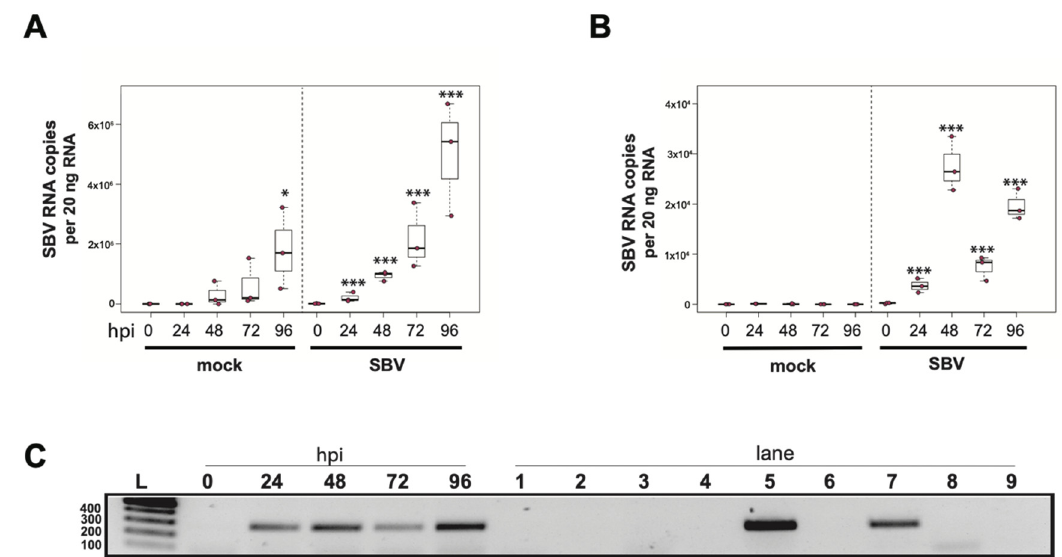
Figure 1. Sacbrood virus (SBV) naturally infects hemocytes and replicates in primary honey bee hemocyte cell cultures. SBV abundance was assessed in mock- or SBV-treated larval hemocytes by qPCR over a time course (i.e., 0 hpi, 24 hpi, 48 hpi, 72 hpi, and 96 hpi). ( A ) Cells isolated from asymptomatic larvae and treated with PBS (pH 7.4) had a 501 × increase in mean SBV abundance by 96 hpi relative to 0 hpi ( p = 0.042), indicating that the hemocytes in this experimental replicate had a pre-existing SBV infection and that hemocytes are a natural site of infection for SBV. The addition of filtered larval lysate containing 2.5 × 10 6 SBV RNA copies resulted in a 13 × increase by 24 hpi relative to 0 hpi ( p < 0.001) and a peak fold increase of 355 × by 96 hpi ( p < 0.0001). ( B ) In a second replicate of the experiment, mock-infected cells remained uninfected over the course of the experiment. The addition of filtered larval lysate containing 2.5 × 10 6 SBV RNA copies resulted in a peak fold increase of 182 × ( p < 0.0001) at 48 hpi, with a decrease at 72 hpi (49 × relative to 0 hpi, p < 0.0001) and a subsequent rise again at 96 hpi (132 × relative to 0 hpi, p < 0.0001). Raw data are included in Supplemental Table S2. All differences in means relative to 0 hpi were assessed by a Dunnett’s test. Significance levels: * p < 0.05; *** p < 0.0005. ( C ) To confirm that SBV was productive in infecting larval hemocytes, the presence of the negative strand (a replicative intermediate) was assessed by negative-strand-specific reverse transcription (RT) followed by PCR. Negative strand was detected at all time points after 0 hpi. Additional control reactions were performed using pooled RNA from time points 24–96 hpi (Lanes labeled 1–9). Specifically, RNA isolated from SBV containing cell lysate was reverse transcribed with the primer listed below, treated with Exonuclease I to remove excess primer, and amplified using the PCR primers listed for each lane. (L) Molecular weight ladder. (0, 24, 48, 96 hpi)—RT with random hexamers, PCR with SBV-221-240-For and SBV-478-497-Rev. (1) Negative control: No RT in the presence of (SBV-TAGS-F), PCR with TAGS and SBV-478-497-Rev. (2) Negative control: RT in the presence of (SBV-TAGS-F), PCR with only the SBV-478-497-Rev primer. (3) Negative control: RT with random hexamer primer, PCR with TAGS and SBV-478-497-Rev. (4) Negative control: No RT enzyme in the presence of random hexamers, PCR with SBV-221-240-For and SBV-478-497-Rev. (5) Positive control: RT with random hexamers, PCR with SBV-221-240-For and SBV-478-497-Rev. (6) Negative control: RT with random hexamers, PCR with only SBV-478-497-Rev primer. (7) Self-priming: RT without a primer, PCR with SBV-221-240-For and SBV-478-497-Rev. (8) Negative control: No template, no RT, PCR with TAGS and SBV-478-497-Rev. (9) Negative control: No template, no RT, PCR with SBV-221-240-For and SBV-478-497-Rev. Additional details provided in Supplemental Table S25. When reverse transcription was performed without primer, SBV cDNA was detectable (lane 7), indicating that the secondary structure in the RNA genome may serve as a primer for cDNA